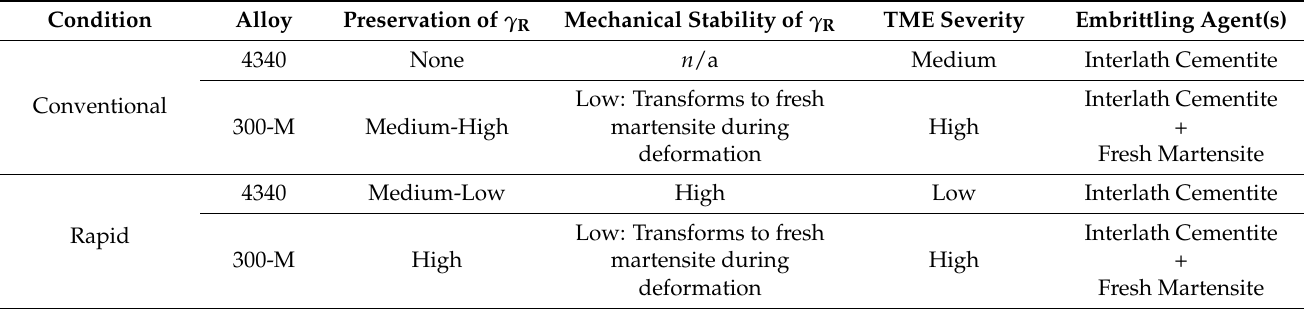
Table 3. Proposed contributions to TME in 4340 and